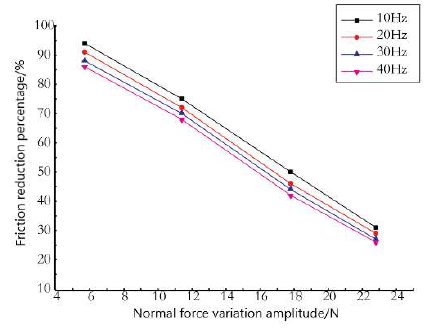
Figure 7. Graph showing Q235A steel and -steel friction pair’s percentage of friction reduction varying with the normal force amplitude’s change.